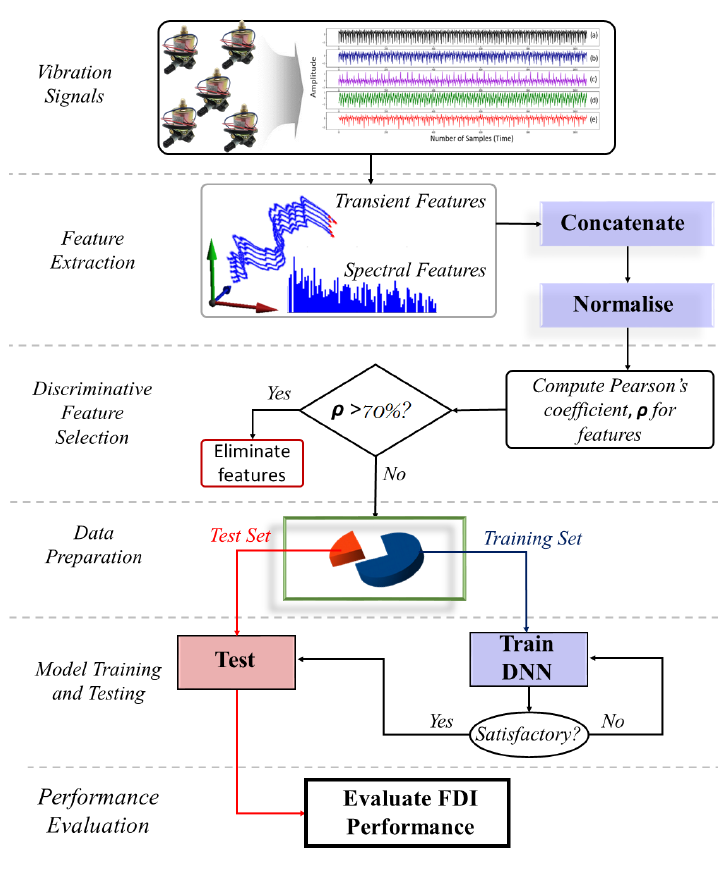
Figure 2. Proposed system